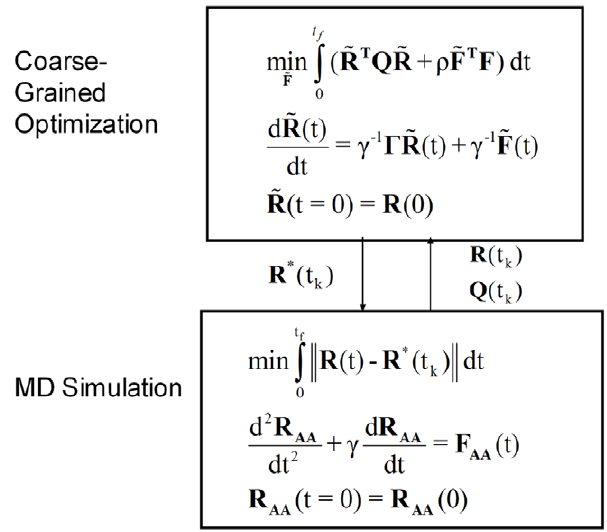
Figure 2. Block diagram representation of the method.